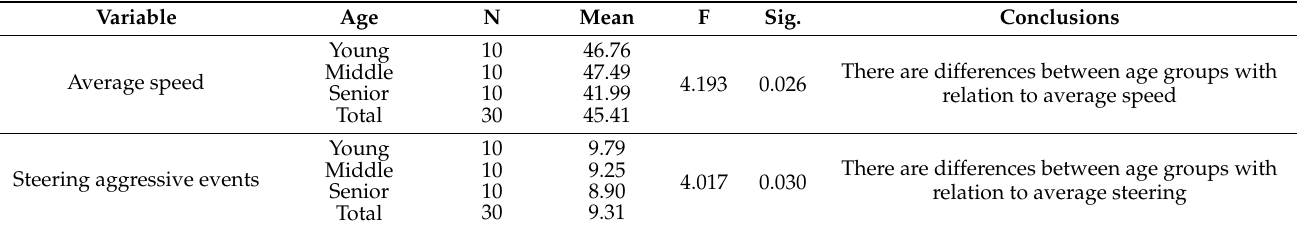
Table 7. Statistical differences in age group.